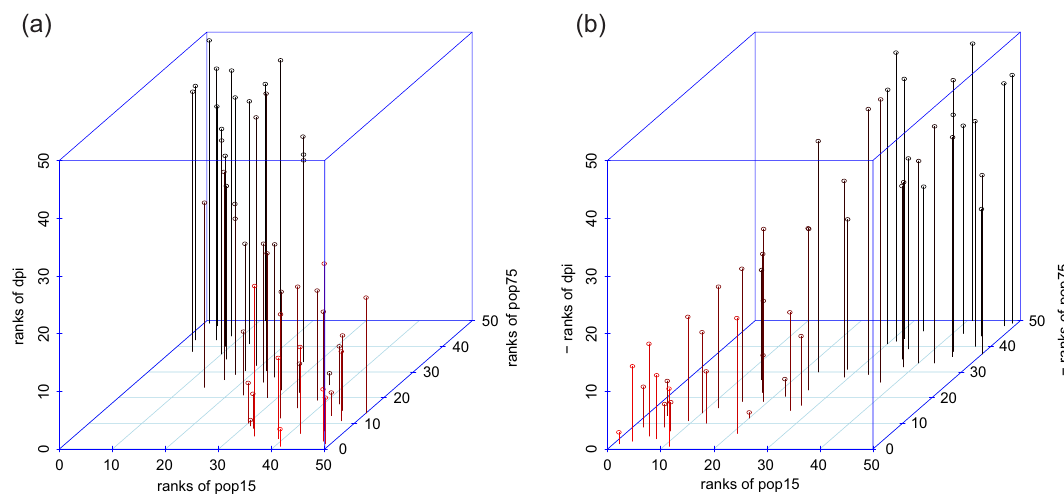
Figure 3. (a) Scatterplot between ranks of pop15, ranks of pop 75 and ranks of dpi, from red to black color in increasing order in relation to the “ ranks of pop75 ” axis. (b) Scatterplot between ranks of pop15, – ranks of pop 75 and – ranks of dpi, since q max ð pop15 ; pop75 ; dpi Þ ¼ q þ ð pop15 ; (cid:4) pop75 ; (cid:4) dpi Þ : From red to black color in increasing order in relation to the “– ranks of pop75 ” 3 3 axis.